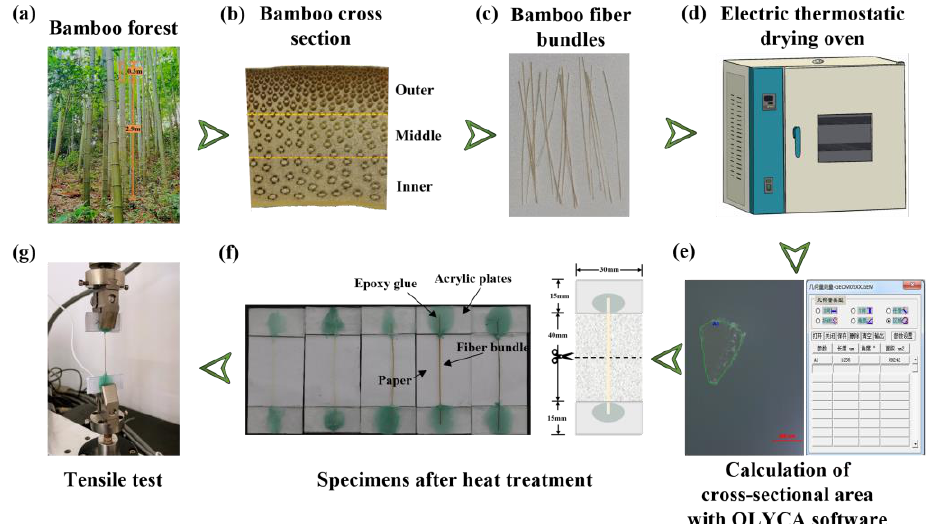
Figure 2. Processing steps and experimental process.